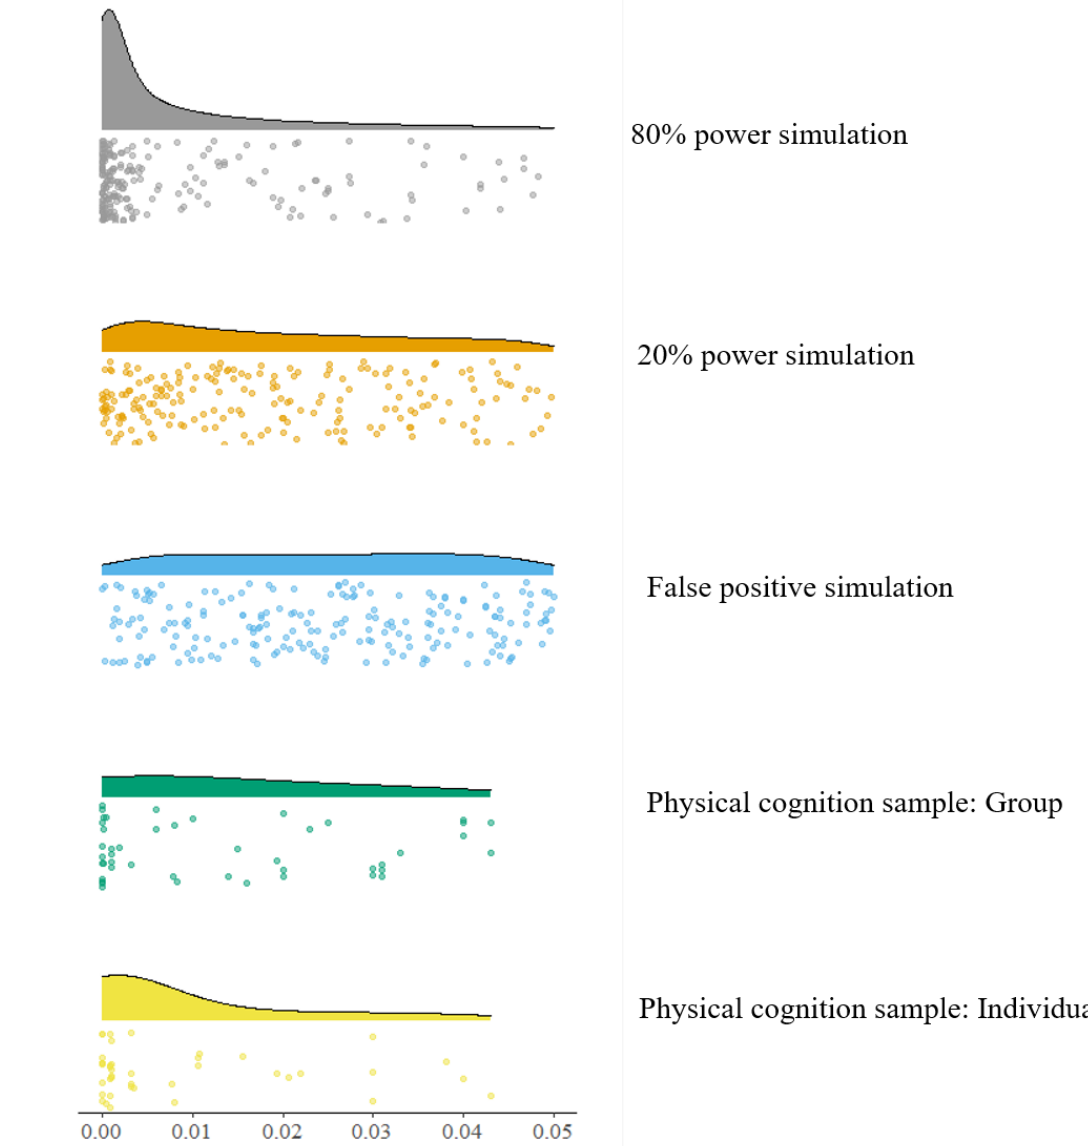
Raincloud Plot of Significant P-Values Observed in Our Physical Cognition Sample and From Simulated Research At